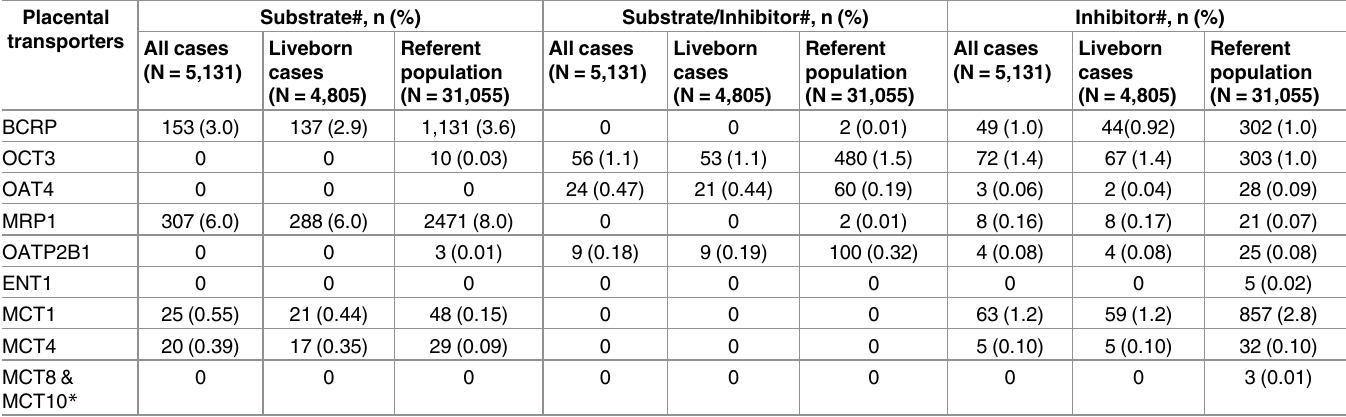
BCRP: breast cancer resistance protein; OCT: organic cation transporter; OAT: organic anion transporter; MRP: multidrug-associated protein; OATP: organic anion transporting polypeptide; ENT: equilibrative nucleoside transporter; MCT: monocarboxylate transporter; # same mother who used more than one drug that belongs to the same substrate classification was counted once; * same drug substrates for both transporters